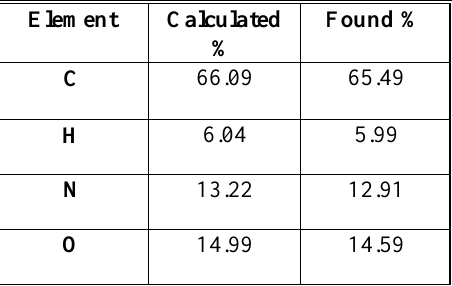
Table 6. Elemental Microanalysis of the isolated